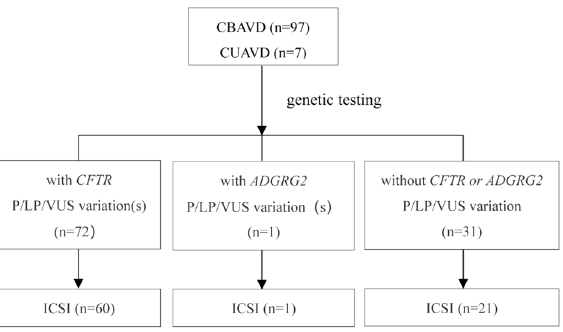
Figure 1. Study flow chart. CBAVD congenital bilateral absence of the vas deferens, CUAVD congenital unilateral absence of the vas deferens, ICSI intra cytoplasmic sperm